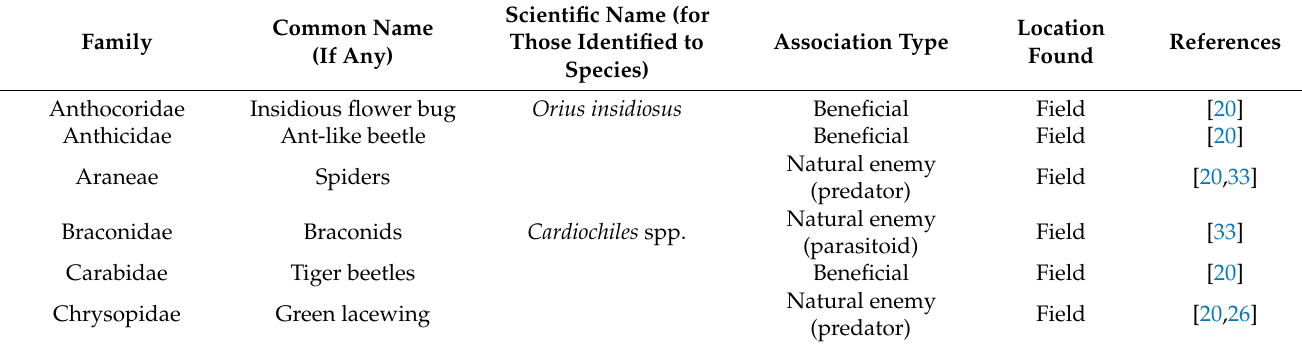
Table 2. A list of some beneficial arthropods reported on hemp in the United